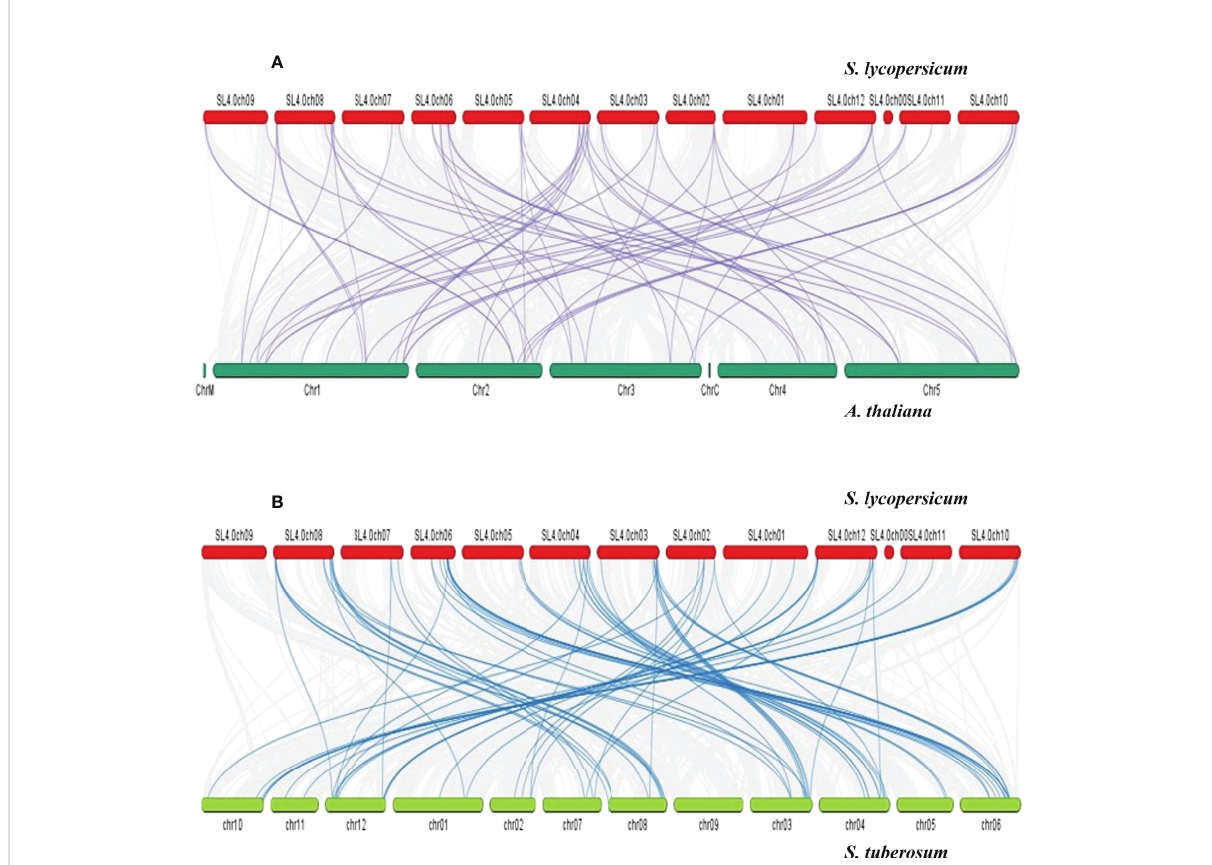
FIGURE 6 Synteny analysis was conducted among (A) S. lycopersicum and A thaliana and (B) S. lycopersicum and S. tuberosum for homology and evolutionary relationship. The red, dark green, and green bars denote the chromosomes of S. lycopersicum , A thaliana , and S. tuberosum . The gray lines indicate the collinear block within genomes. The purple and dark blue lines were designated to the respective homolog dehydration- responsive element-binding genes present between